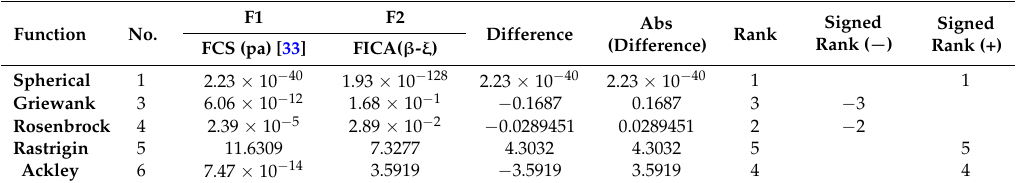
Table 13. Parameters for the statistical test for FICA combination ( β - ξ ) and FCS